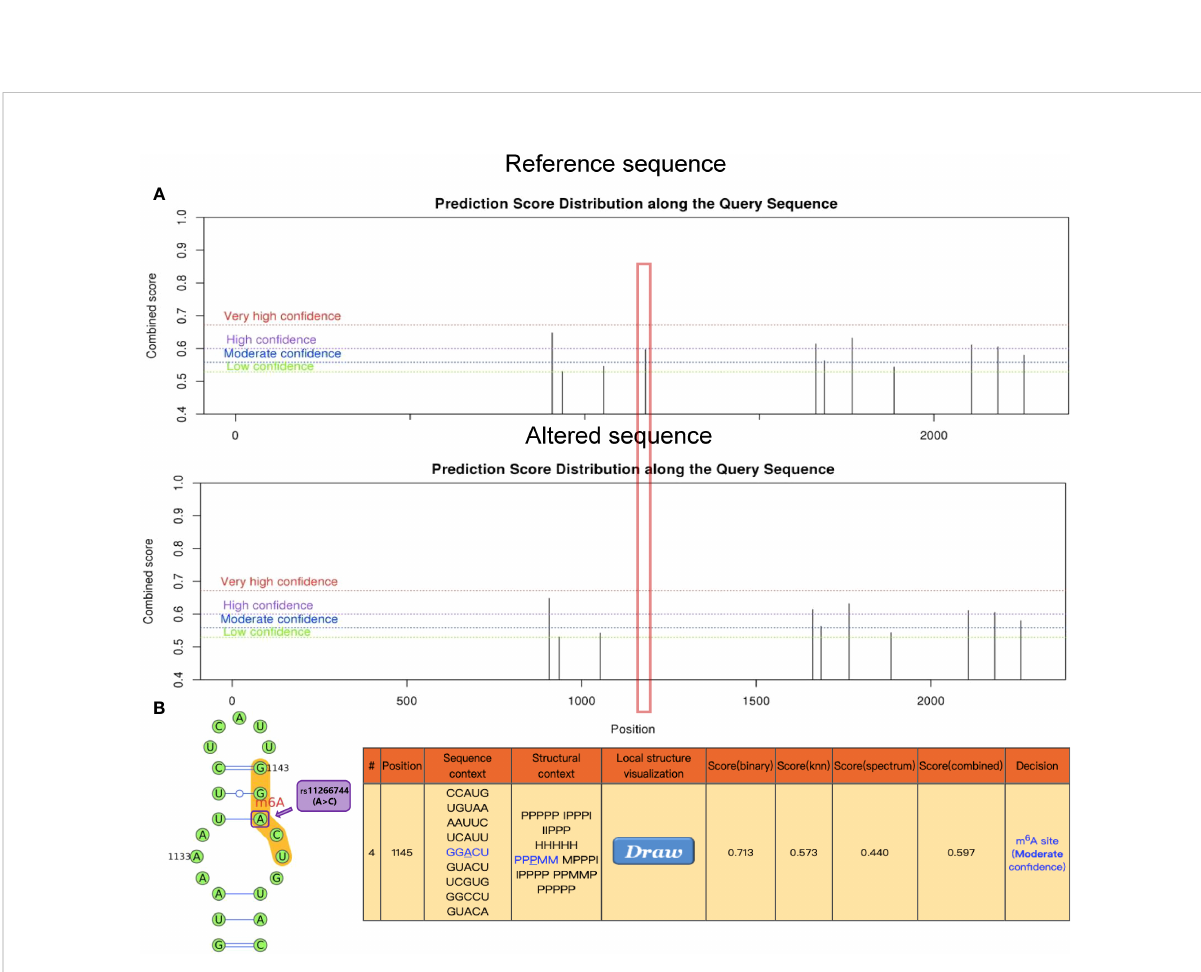
FIGURE 5 The genomic sequence of a representative CCRL2 transcript (ENST00000399036.4) was used to predict the m6A modi fi cation peak on the website (http://www.cuilab.cn/sramp), while secondary structure analysis was enabled. (A) The red box indicates the disappearance of the m6A modi fi ed peak near rs11266744 after inputting the altered sequence. (B) The local secondary structure around mutation site rs11266744 is shown. rs11266744 (A>C) is located in purple at the predicted m6A modi fi cation site (red) with medium con fi dence. In the secondary structure string, H, M, I, B and P refer to hairpin loop, multiple loop, interior loop, bulged loop, and paired residues,